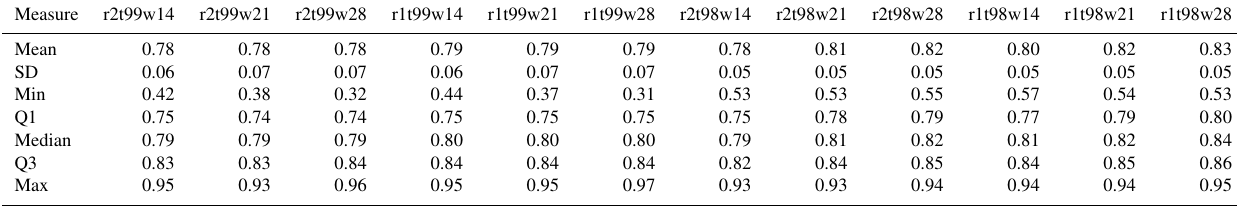
Table F1. Descriptive statistics of the S cont distributions for all parameter combinations. The measures are the same as in Table D1.